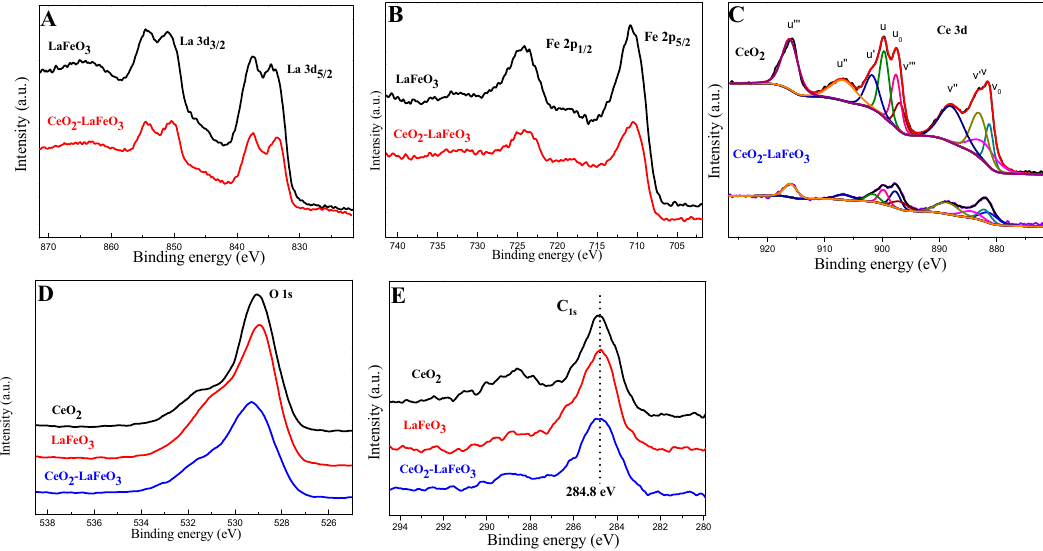
Figure 5. XPS spectra of ( A ) La 3d; ( B ) Fe 2p; ( C ) Ce 3d; ( D ) O 1s for LaFeO 3 , CeO 2 and CeO 2 -LaFeO 3 ; ( E ) C 1s. Table 1. Surface elemental composition/at % of as-prepared catalysts obtained from XPS. Samples Fe Ce La